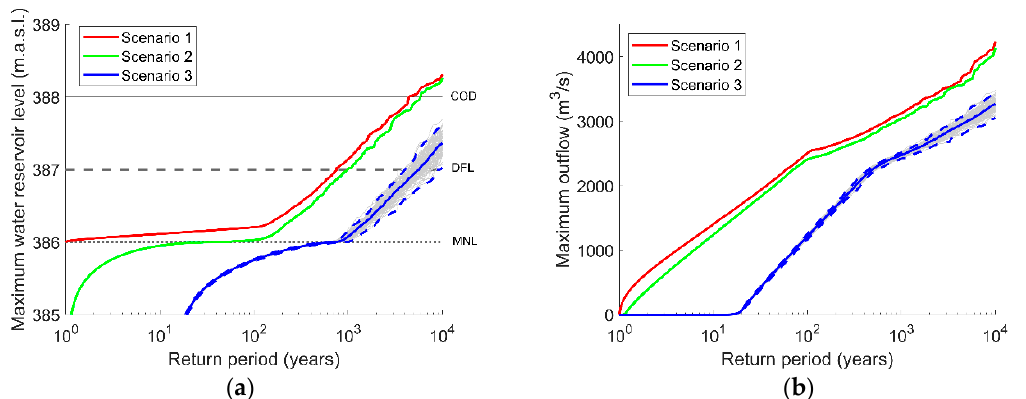
Figure 4. Maximum water reservoir level (MWRL) and maximum outflow (MO) frequency curves. ( a ) Red line represents the MWRL frequency curve assuming the initial level equal to Maximum Normal Level (MNL) (Scenario 1). Green line represents the MWRL frequency curve assuming the initial reservoir level equal to Flood Control Level (FCL) (Scenario 2). Grey lines represent the 1000 MWRL frequency curves, assuming the variable initial level (Scenario 3), being the median of these simulations represented by a blue continuous line and the 2.5% and 97.5% percentiles, with blue dashed-lines. The dotted grey line represents MNL, dashed grey line represents the Design Flood Level (DFL), continuous grey line represents the COD. ( b ) Same as figure ( a ) but applied to Maximum